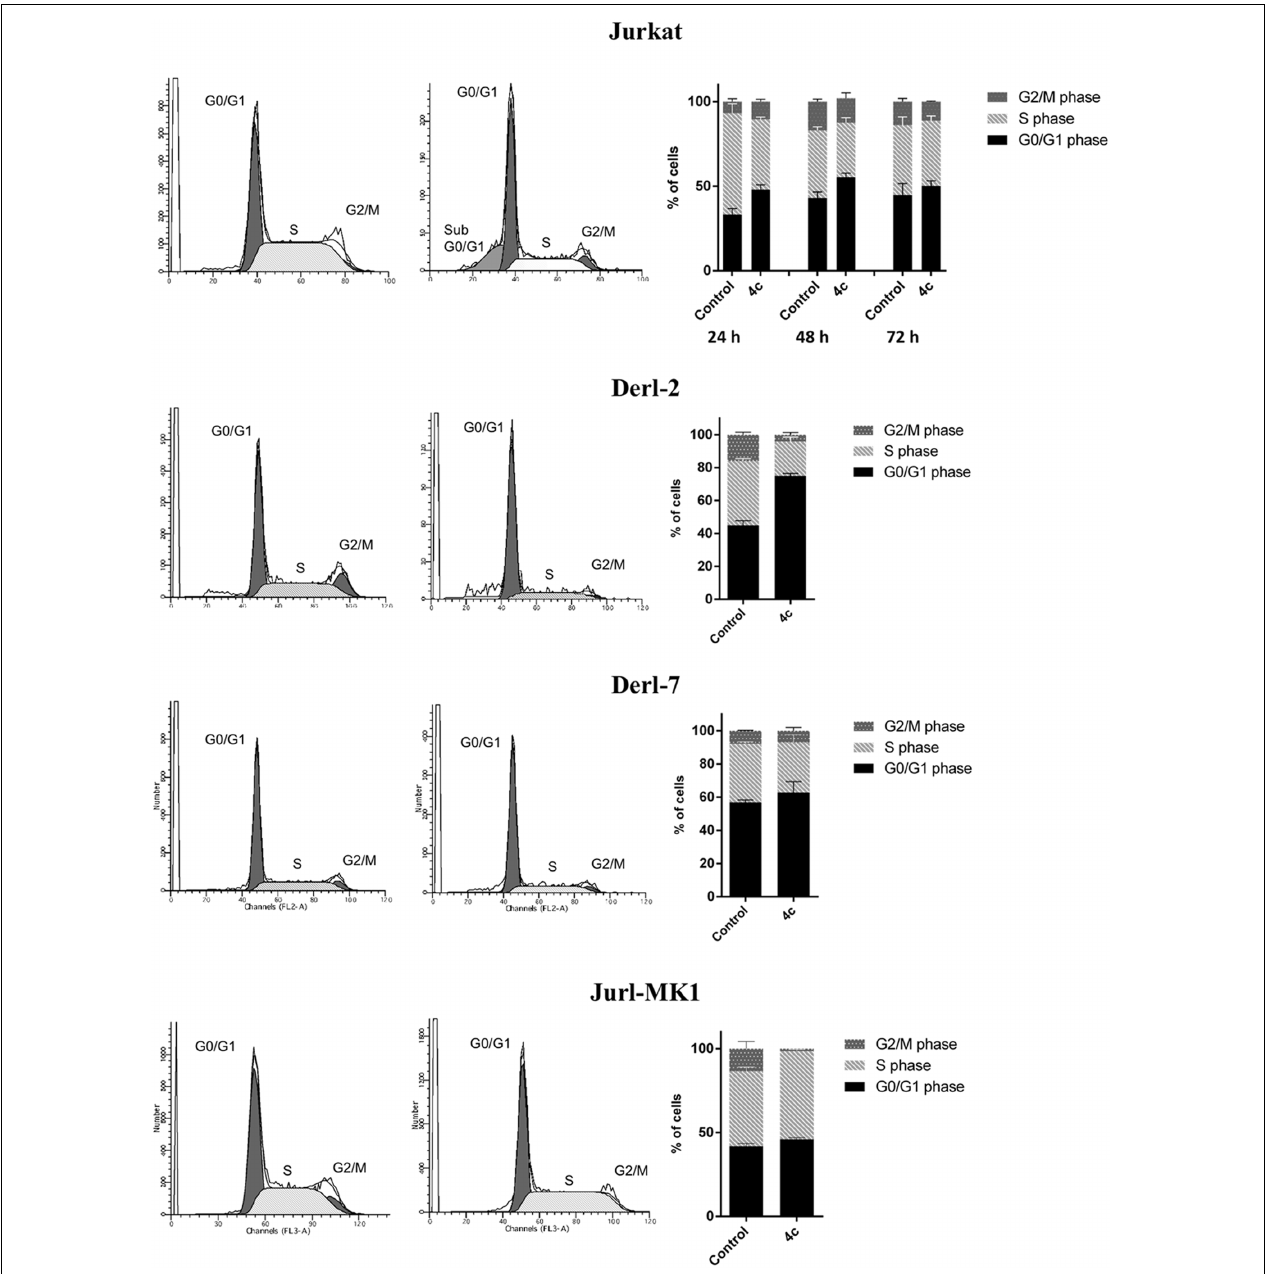
FIGURE 3 | Cell cycle analysis in hematological malignancies after 4c compound treatment. Cell cycle analysis was evaluated by flow cytometer in Jurkat cell line after 4c compound or DMSO vehicle treatment at 2 µ M for 24, 48, and 72 h; in Derl-2 and Derl-7 after treatment at 4 µ M for 72 h; in Jurl-MK1 after treatment at 1 µ M for 72 h. Histogram plots show a single representative experiment, the bar-graphs represent mean with SD from three independent